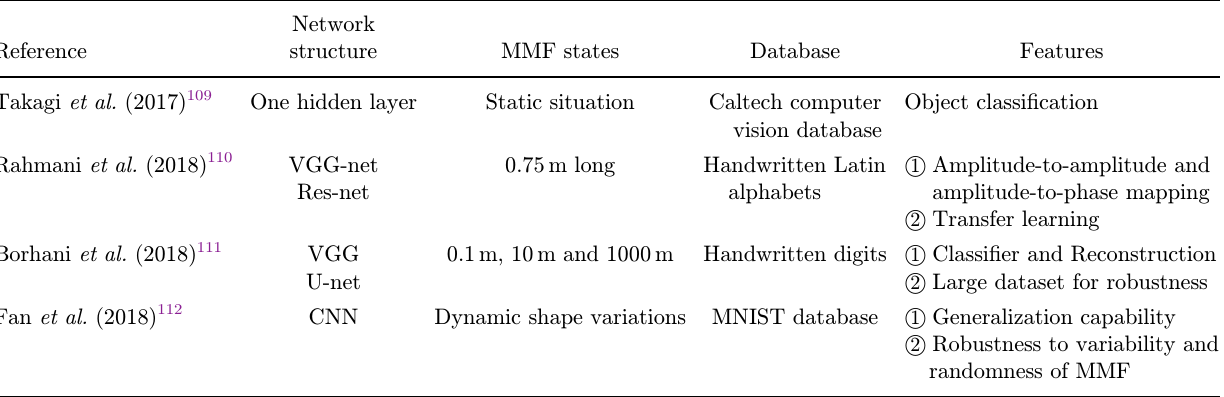
Table 1. Summary of recent deep learning approaches for image transmission through